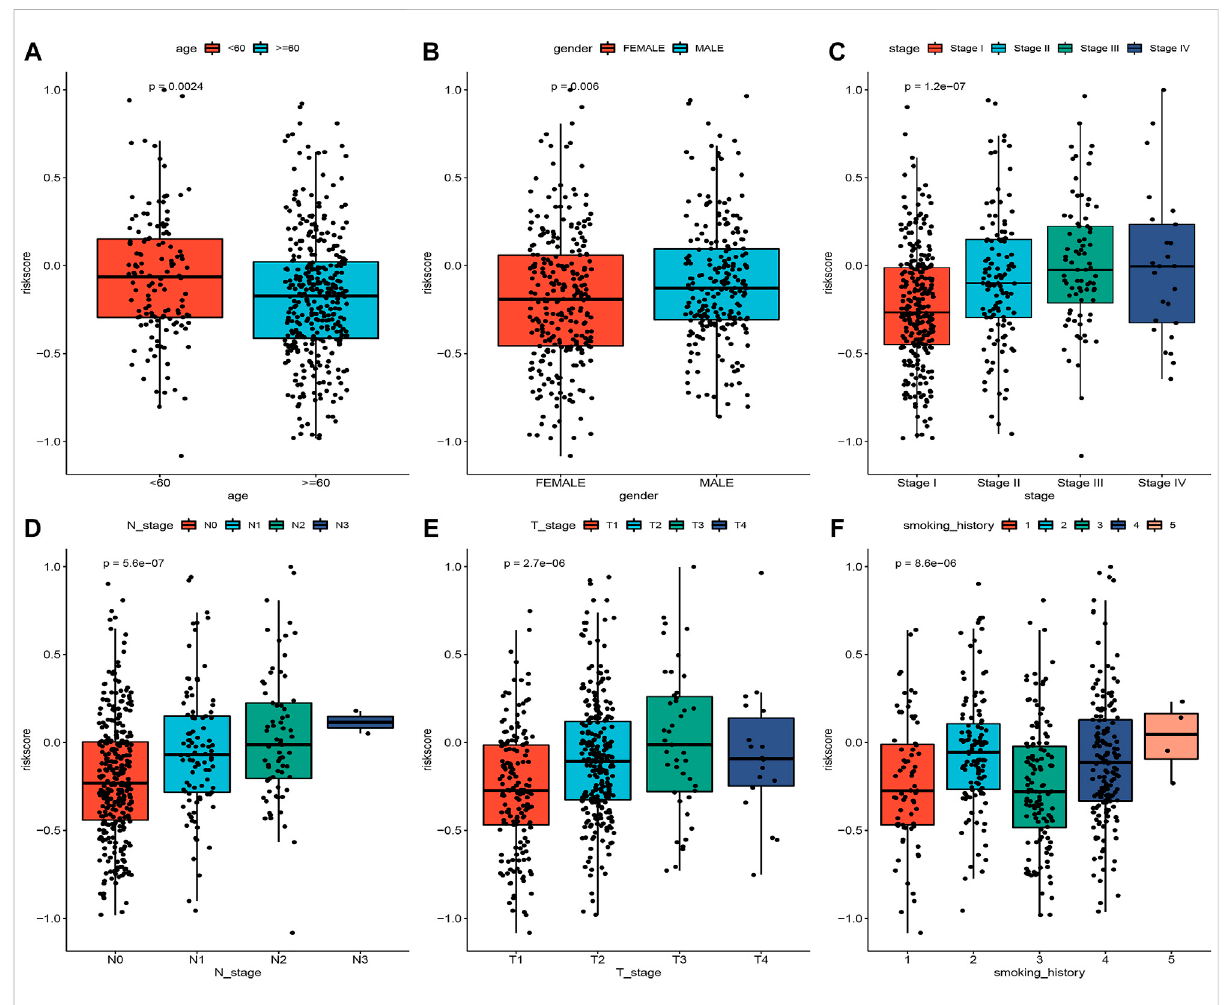
FIGURE 5 Correlation between risk scores and different clinical characteristics (A – F)